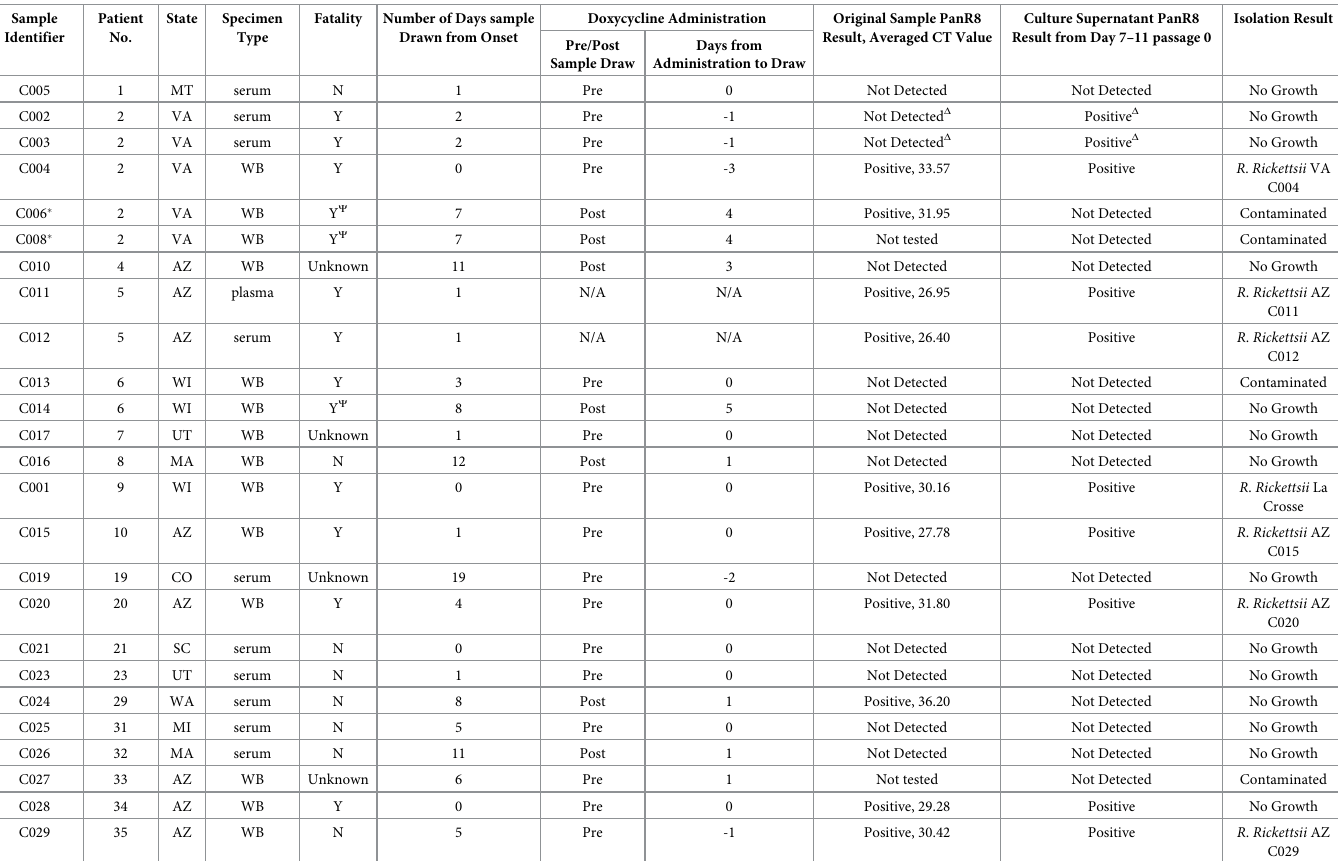
Table 3. Summary of clinical samples. Sample